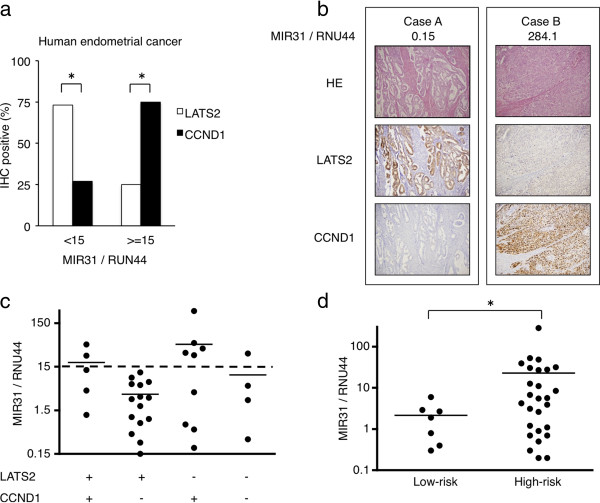
Correlation between the MIR31 expression and the immunohistochemical detection of LATS2 and CCND1 in human EC cells. (a) Proportion of patients with positive staining for LATS2 and CCND1 classified into the MIR31 > =15 and MIR31 < 15 groups. *p < 0.05, Chi-square test. (b) The MIR31 expression assessed using qRT-PCR with RNU44 as the endogenous control (top) and representative micrographs, x100. (c) The MIR31 expression levels in all patients classified according to staining for LATS2 and CCND1 are shown in the scatter diagram. The horizontal solid lines indicate the mean. (d) The expression levels of MIR31 in the human EC cells were analyzed using qRT-PCR. The horizontal lines demonstrate the mean. *p < 0.05, Mann-Whitney's U-test.